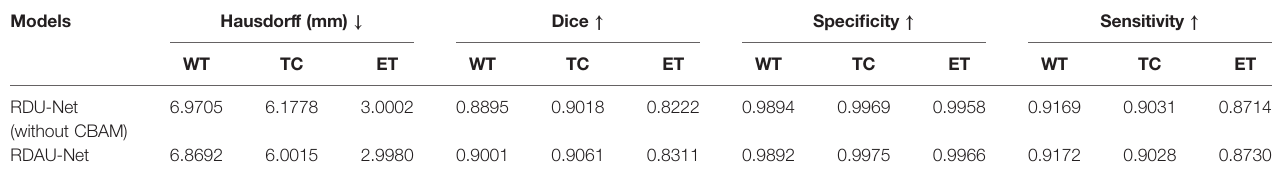
TABLE 1 | Segmentation results of our proposed network with and without attention mechanism on BraTS 2019 validation set using Dice, Hausdorff distance, speci fi city, and sensitivity metrics.